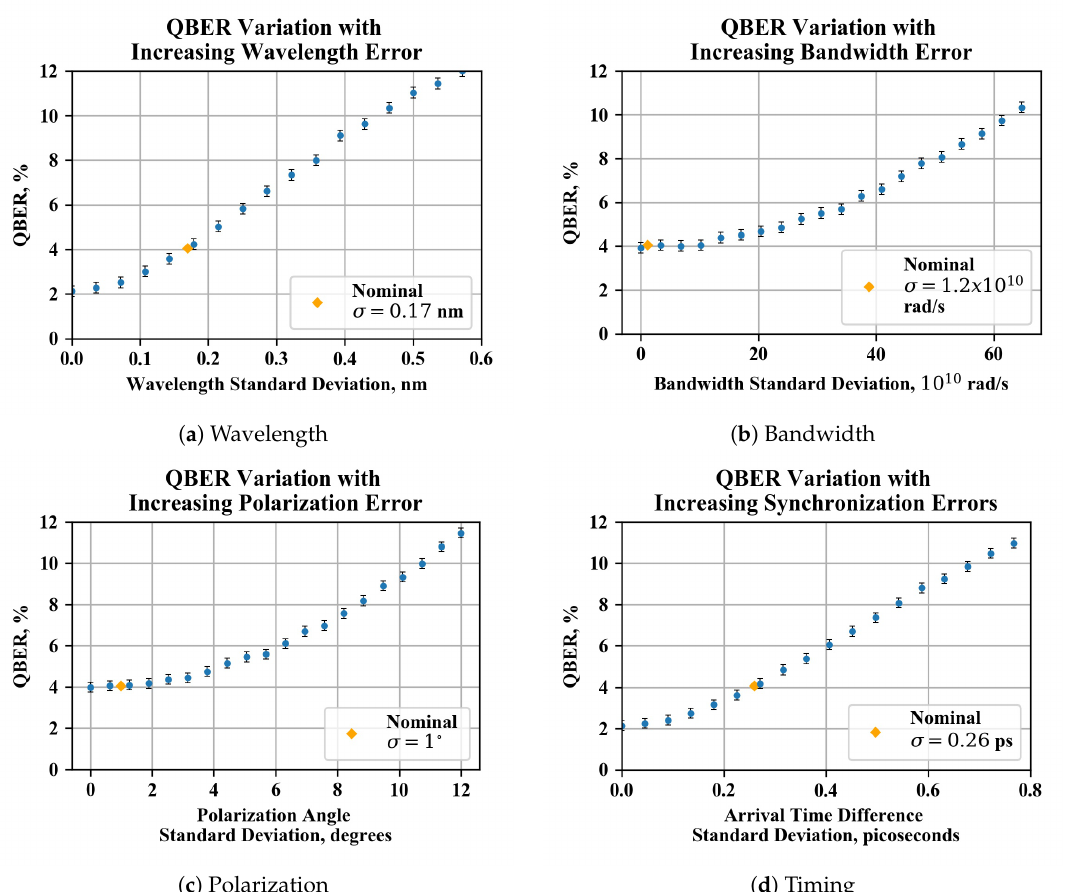
Figure 4. Dependence of the QBER on photon source tolerances for a single variable. The QBER values are averaged over 100 trials of N raw = 2500 with uncertainty dominated by shot noise. Error bars represent three times the standard deviation of the mean in either